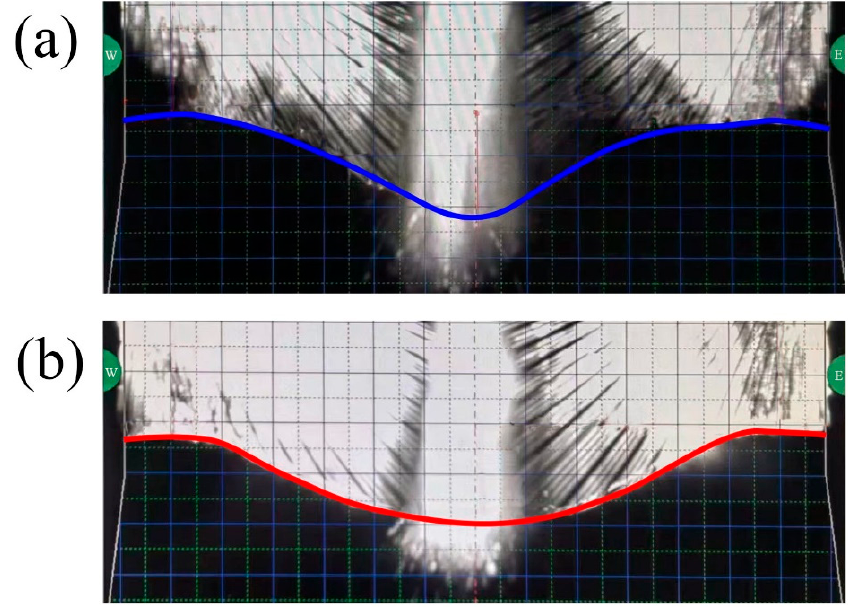
Figure 1. Blast furnace burden surface measured diagram: ( a ) coke burden surface shape; ( b ) ore burden surface shape.